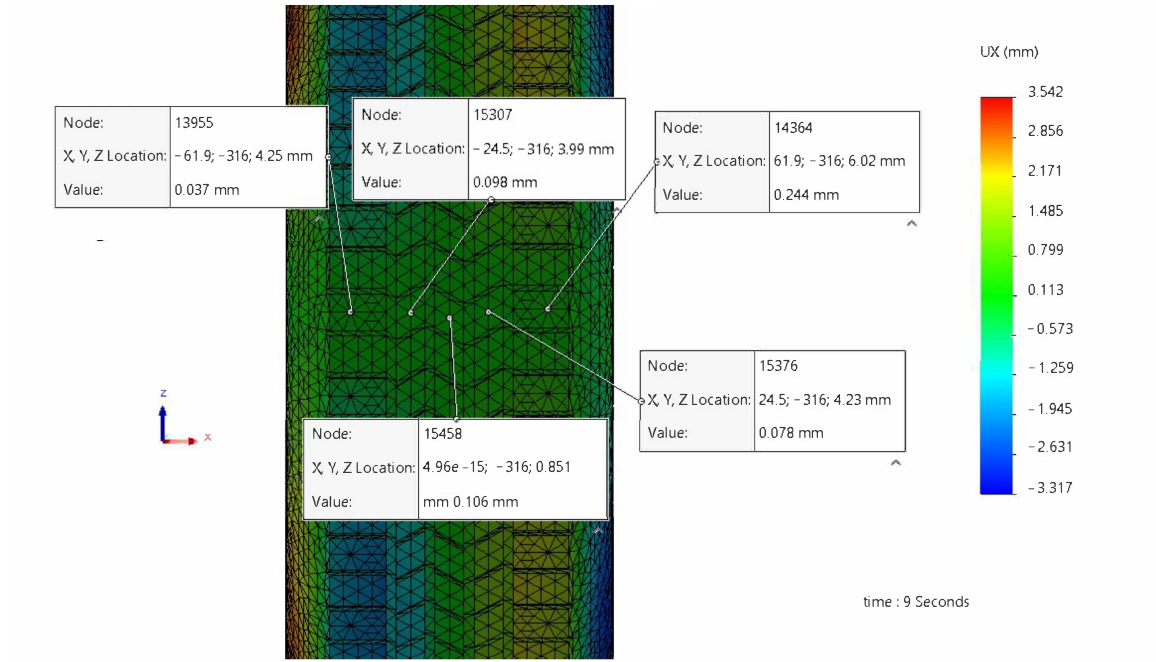
Figure 7. Displacements of tyre